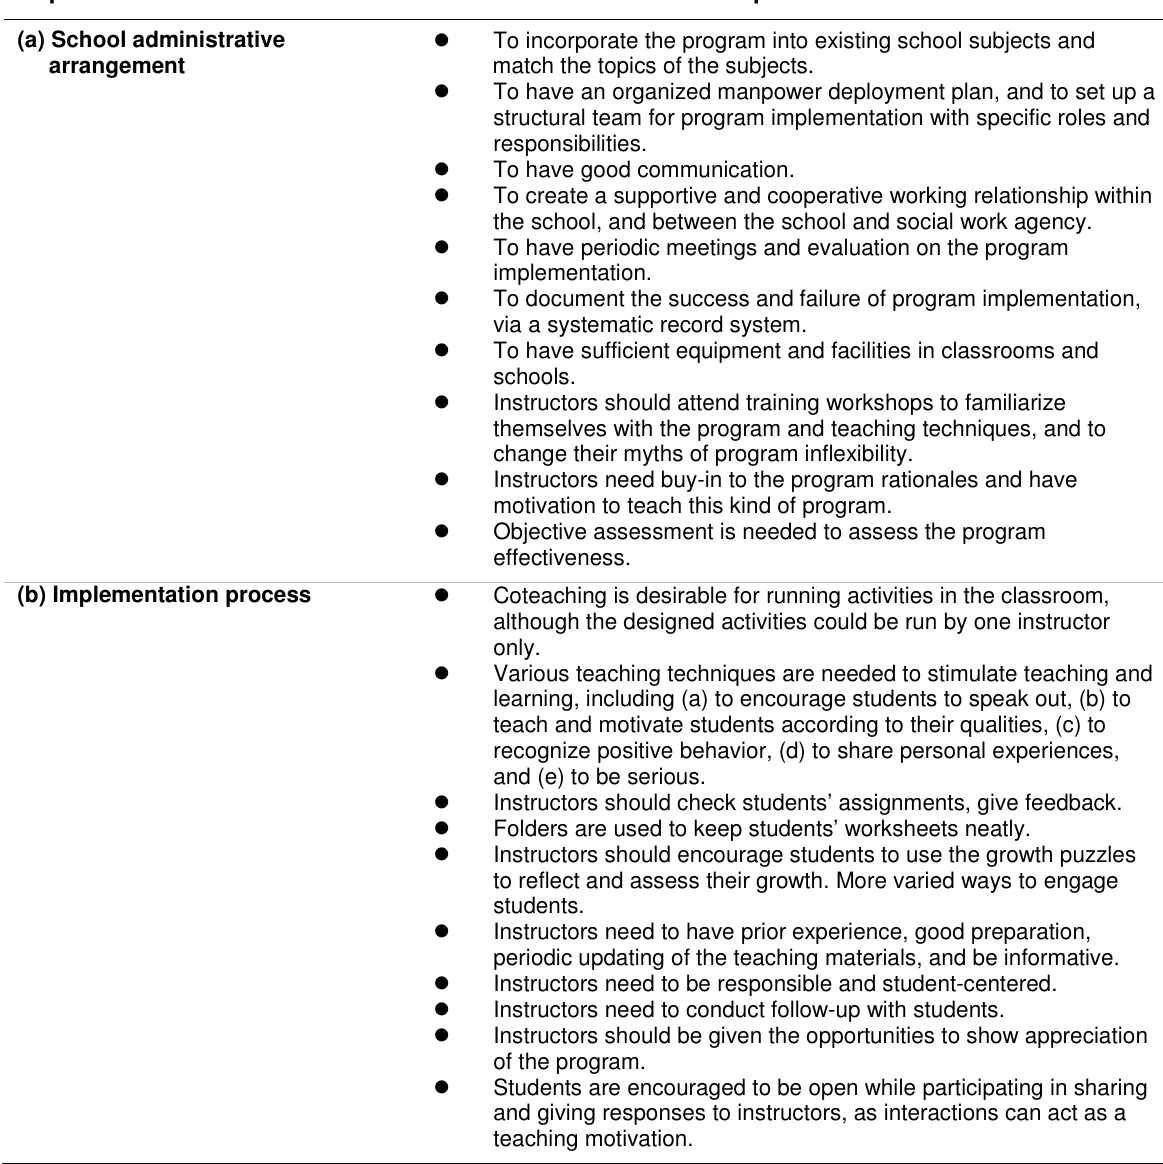
Implications of the Findings for Future Implementation